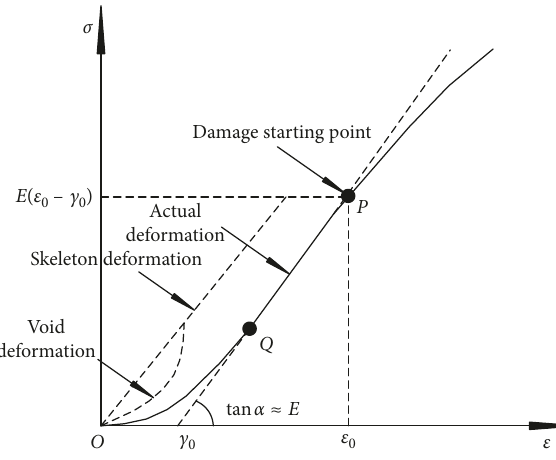
Figure 3: Characteristics of stress-strain curve at compaction stage σ 3 ( σ 2 (cid:31) (cid:31)